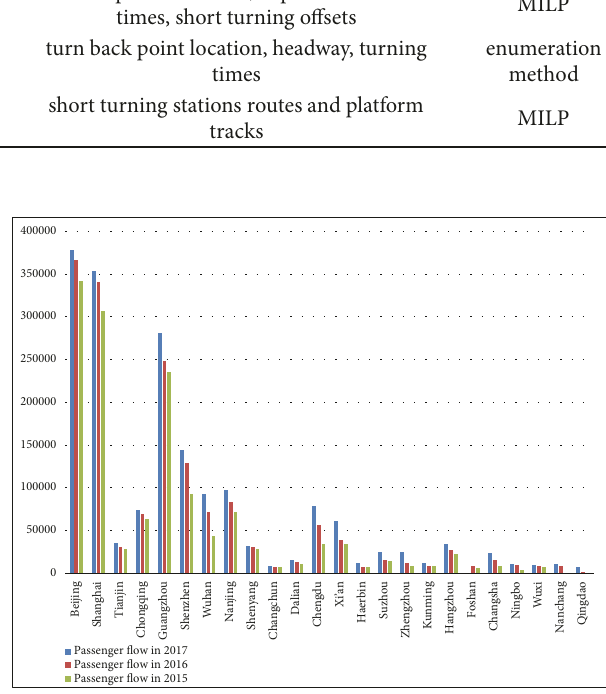
Figure 1: Comparison of passenger flows in 2015, 2016, and 2017 for the metro systems in the cities of